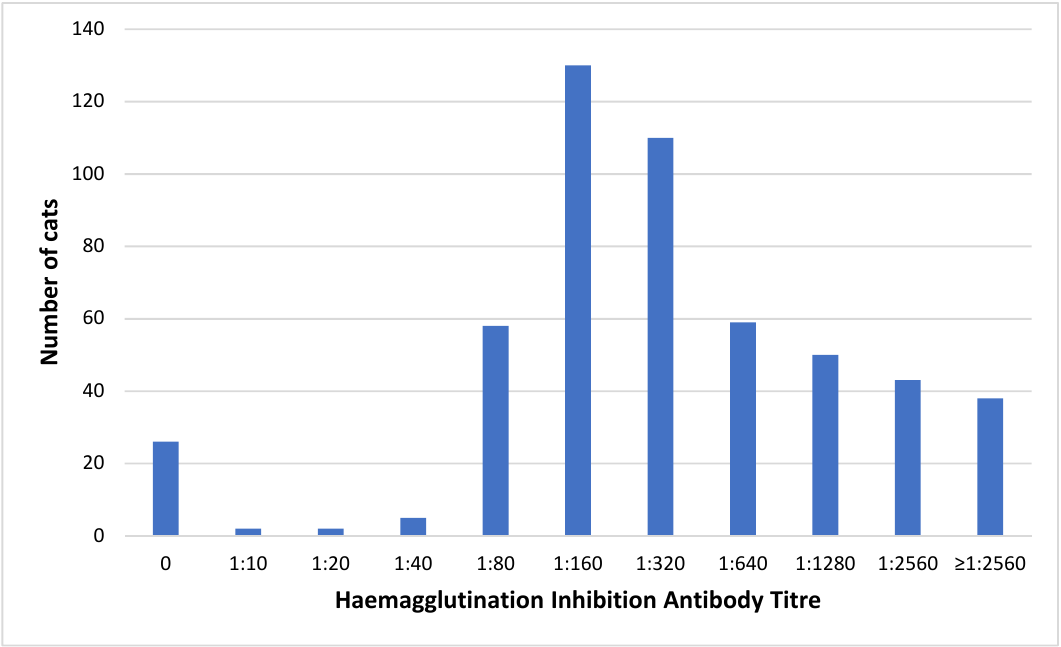
Figure 2. Frequency distribution of serum FPV haemagglutination inhibition titres among all cats tested in this study ( n = 523).